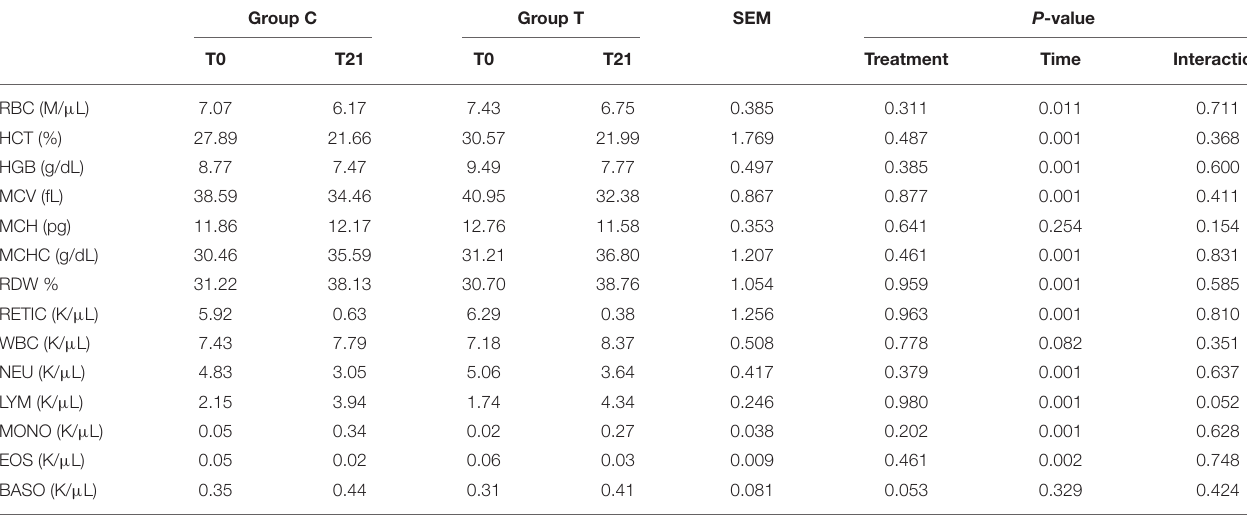
MONO (K/ µ L) BASO (K/ µ L)